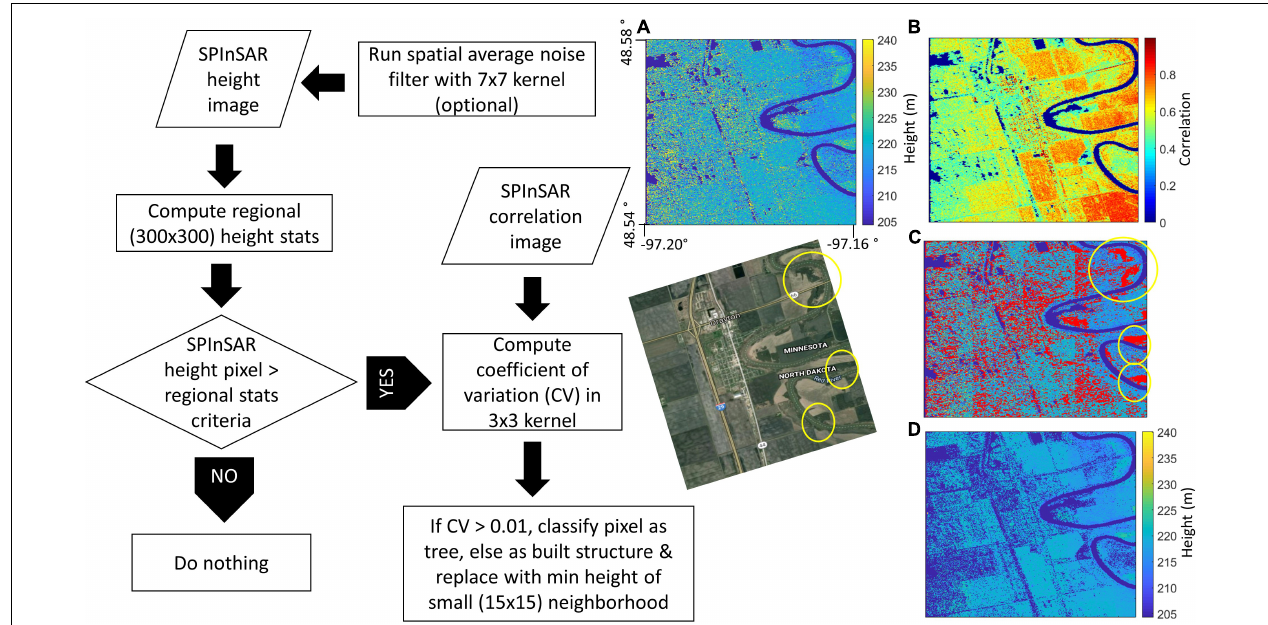
FIGURE 4 | Flowchart and results of classifier based on informed relationships between InSAR height and correlation image data. Results: (A) Original SAR height image; (B) SAR signal correlation image; (C) SAR height image in (A) with pixels identified by the classifier in red; (D) Resulting SAR height image at 3 × 3 m before spatial aggregation to a bare-earth DEM, with tall vegetation (trees, etc.) and built structures successfully removed. The Google satellite image shown for visual comparison highlights classified groves of trees along the meandering Red River of the North. Note that shorter vegetation and the state of agricultural fields on the satellite image are not directly comparable to the SAR data that were acquired at a different time and during late